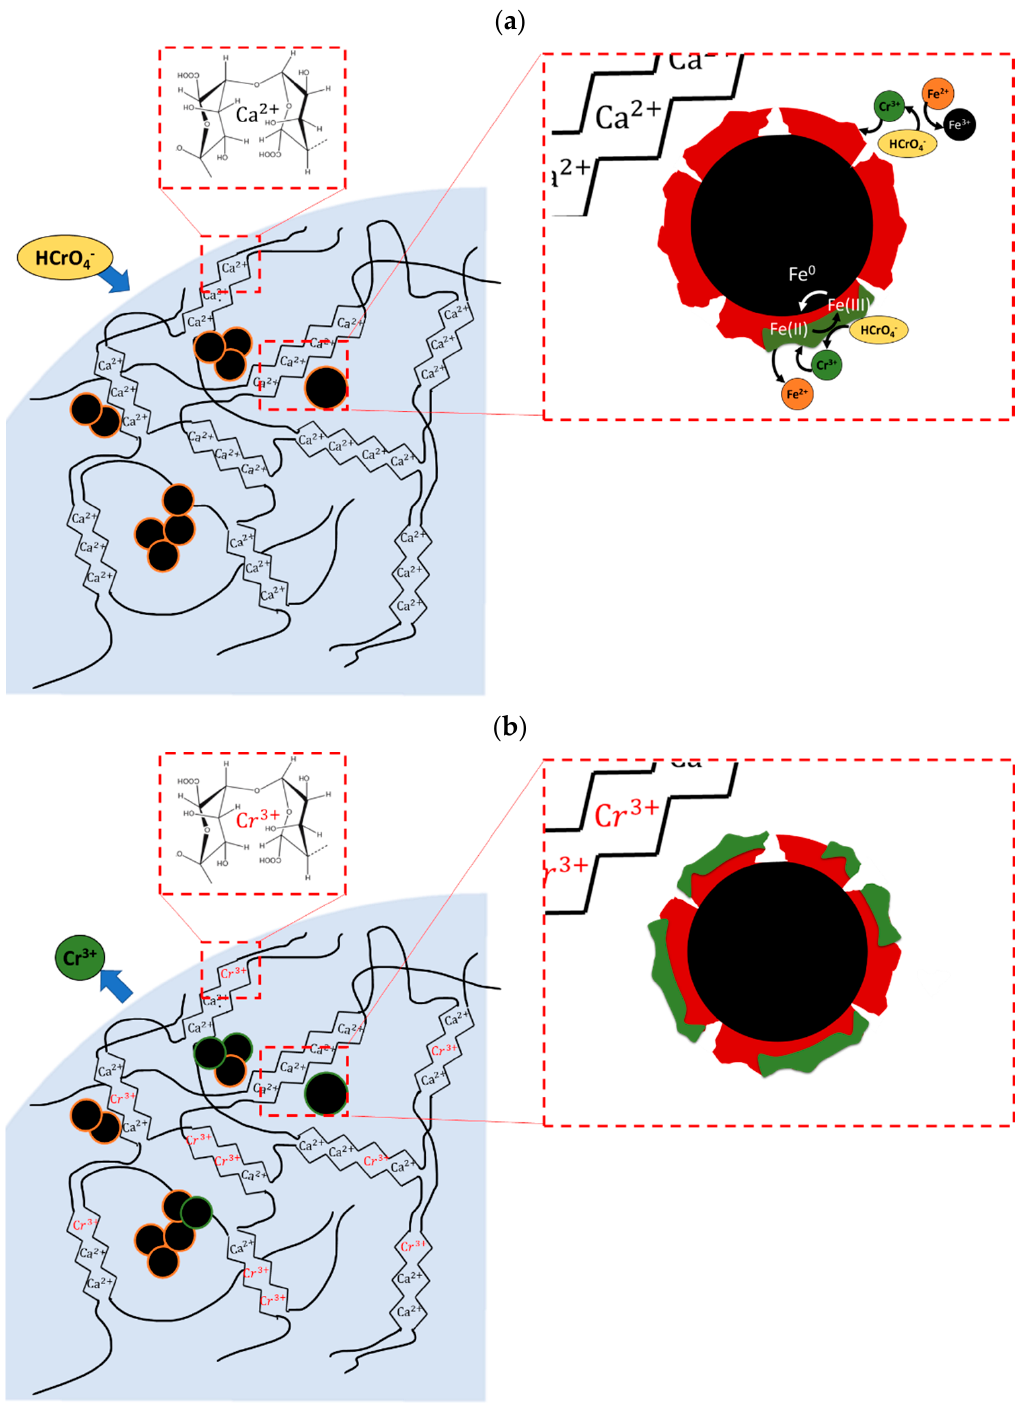
Figure 7. Schematic representation of Cr(VI) removal by nZVI@AL. ( a ) Cr(VI) penetration into the beads, and reaction with nZVI. ( b ) Cr(III) fate and distribution after reaction.